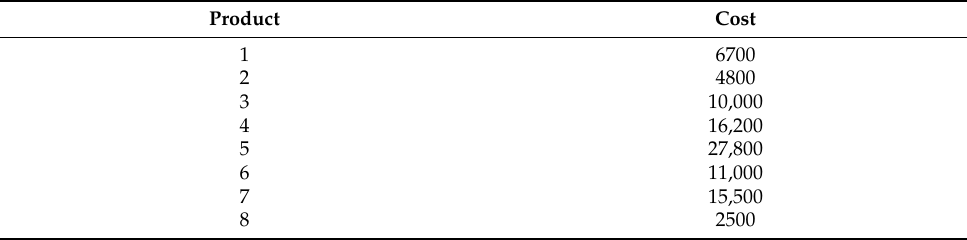
Table 9. Costs to Purchase from Outside (IDR